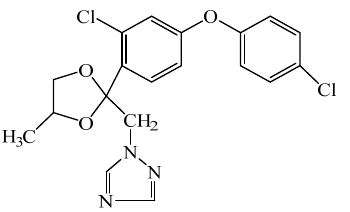
Figure 1. The chemical structural formula of difenoconazole.